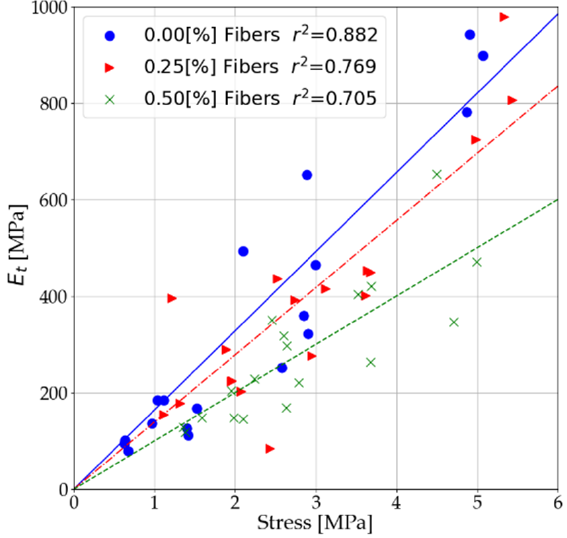
Figure 13. Influence of fibers on the relationship of tangent moduli at 0.5 R c and ultimate compressive strength. Table 9. Parameter A for determining the prediction of modulus values for stabilized soils. Fibers Content of